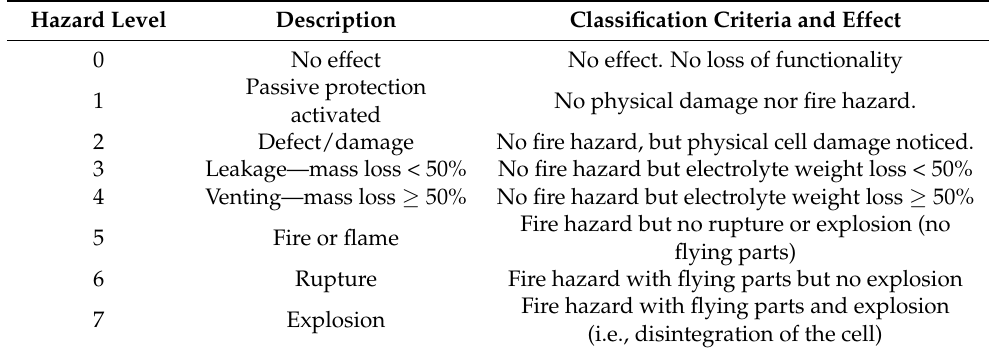
Table 1. EUCAR Hazard Severity Levels